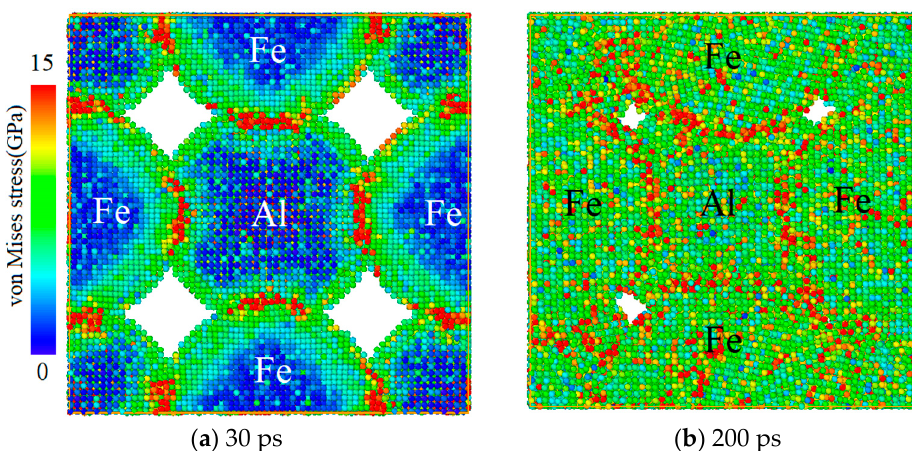
Figure 7. Stress distribution during model relaxation.